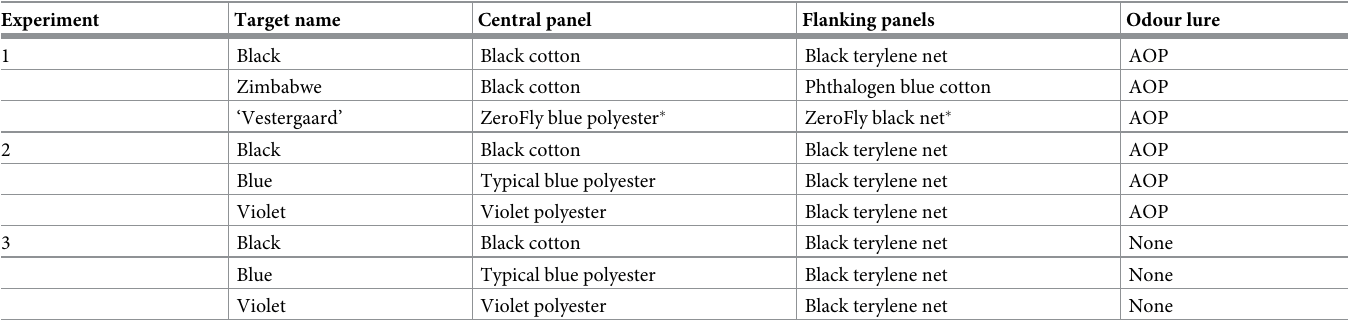
Table 1. Target designs tested in the three experiments of the current